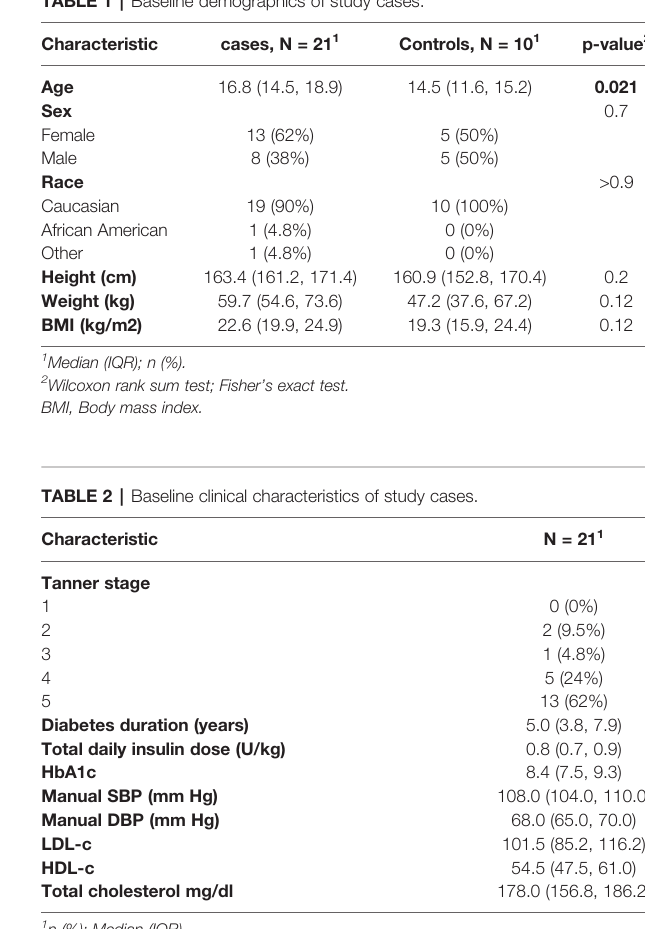
TABLE 1 | Baseline demographics of study cases.